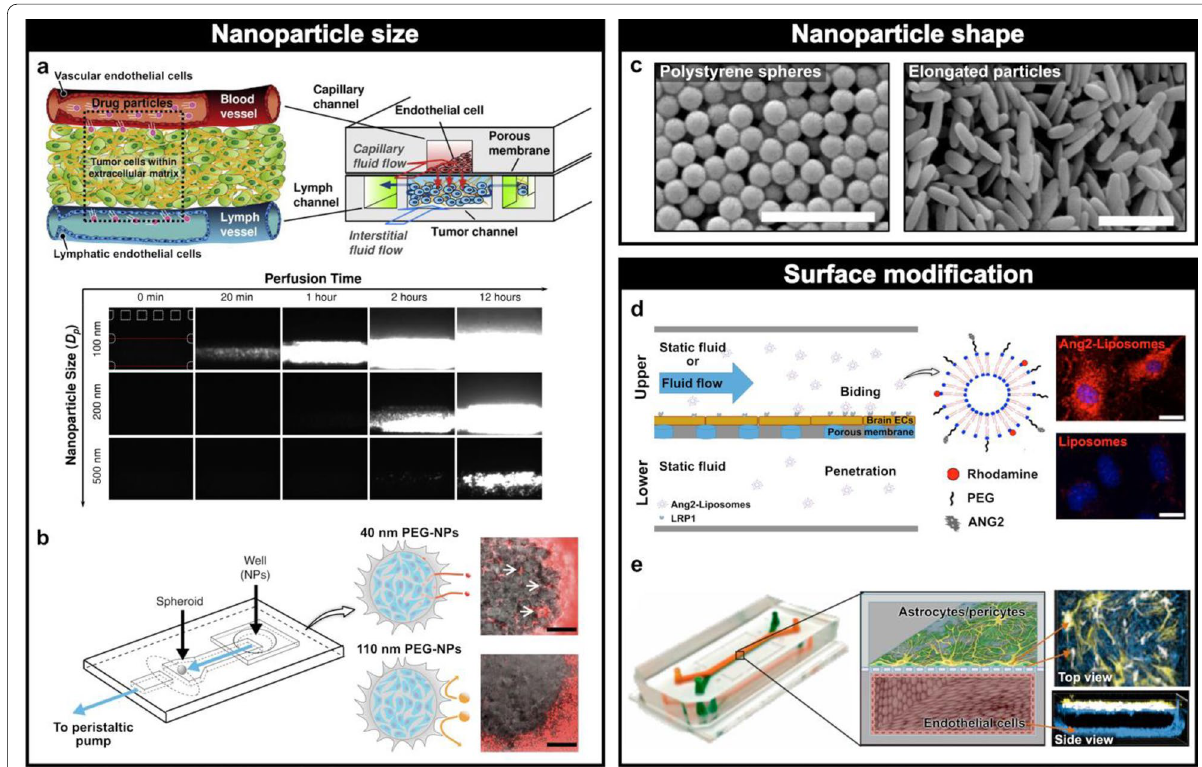
Fig. 2 Effect of nanoparticle physicochemical properties. a A microengineered breast cancer tumor model mimicking the blood vessels, tumor tissue, and lymph vessels through three different types of channels demonstrated the correlation between smaller nanoparticle sizes and increased translocation across a porous membrane. b A tumor-on-a-chip model to assess nanoparticle accumulation at a tumor spheroid. Small particles were able to accumulate at the spheroids, whereas larger ones could not. Scale bars, 100 µm. c When anti-intracellular adhesion molecule-1 (ICAM) and immunoglobulin G antibody (IgG) coated nanorods and spheres were flown across a microfluidic device, nanorods demonstrated enhanced targeting and greater attachment to an endothelial monolayer compared to spheres. Scale bars, 1 µm. d A blood brain barrier (BBB) model with two overlapping channels separated by a porous membrane showed greater binding of liposomes modified with Angiopep-2 (Ang-2) to endothelial cells than non-functionalized ones. Scale bars, 10 µm. e A similar human BBB on-chip with human brain astrocytes and pericytes in the upper, central nervous system (CNS) compartment and brain-like microvascular endothelial cells in the lower, brain microvasculature compartment indicated an enhanced ability of Ang-2-coated quantum dots (QDs) to move across the CNS channel without affecting the barrier integrity compared to non-modified